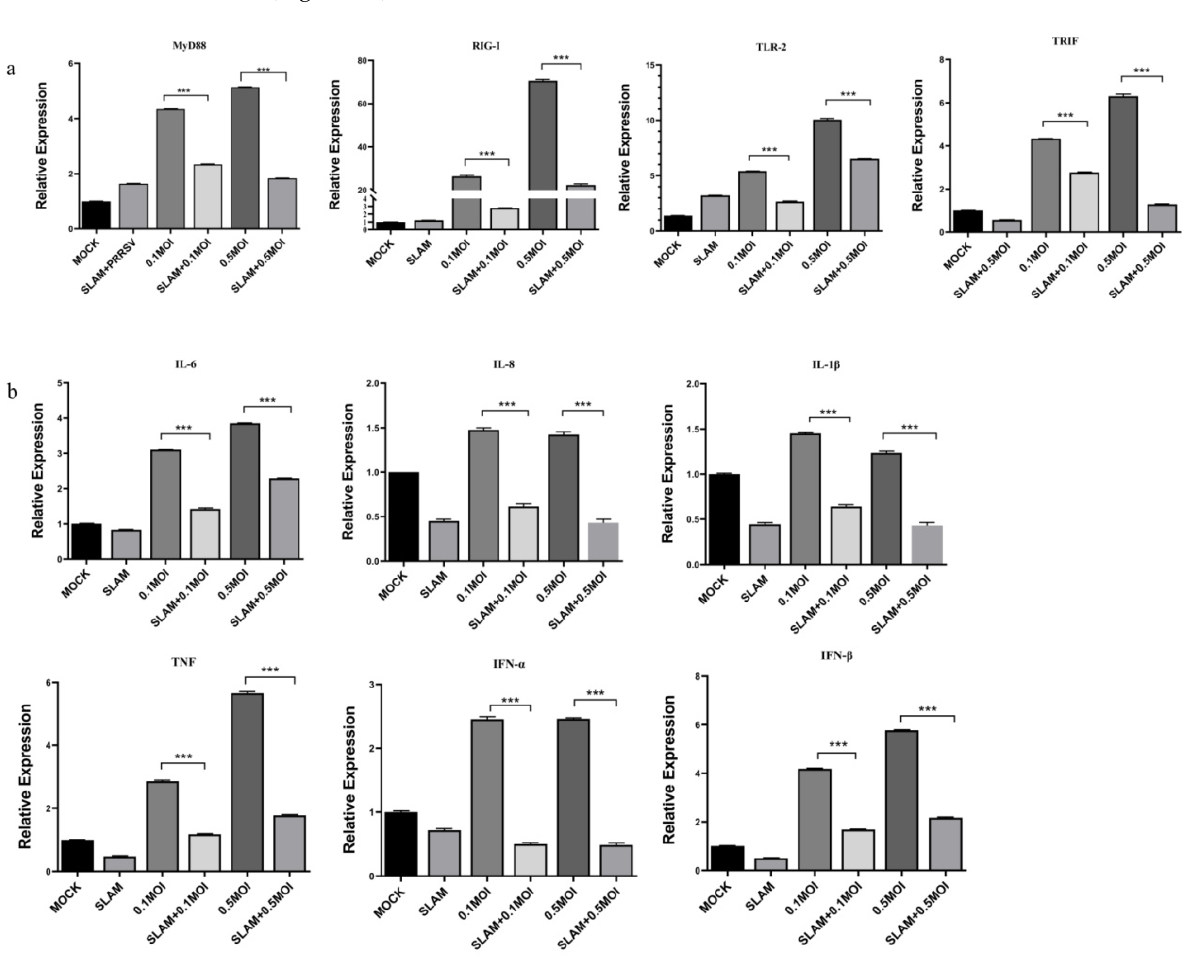
Figure 4. SLAM gene overexpression inhibits PRRSV-induced inflammation. ( a ) Influence of SLAM overexpression on key signaling molecules after PRRSV infection. ( b ) Effects of SLAM overexpression on inflammatory cytokines after PRRSV infection. Note: *** means an extremely significant difference ( p < 0.001).